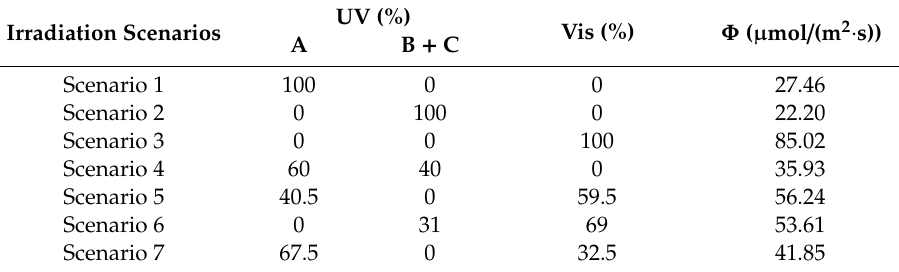
Table 2. Share of UV and Vis radiation and photon